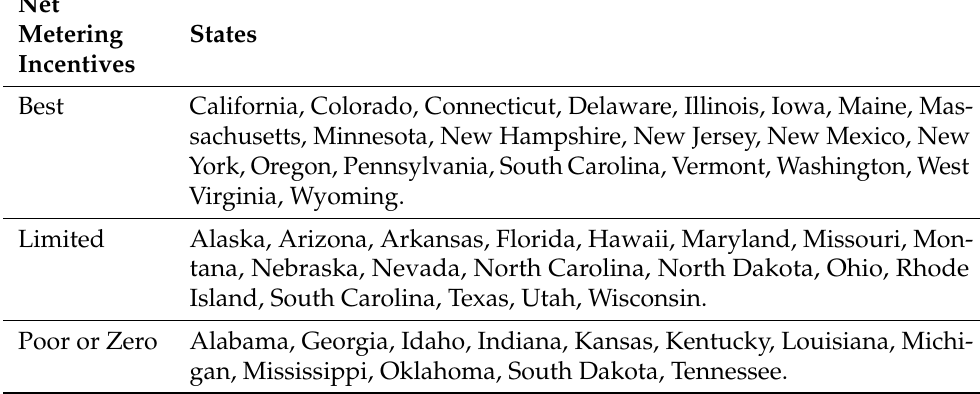
Table 6. Current net metering policies adopted by